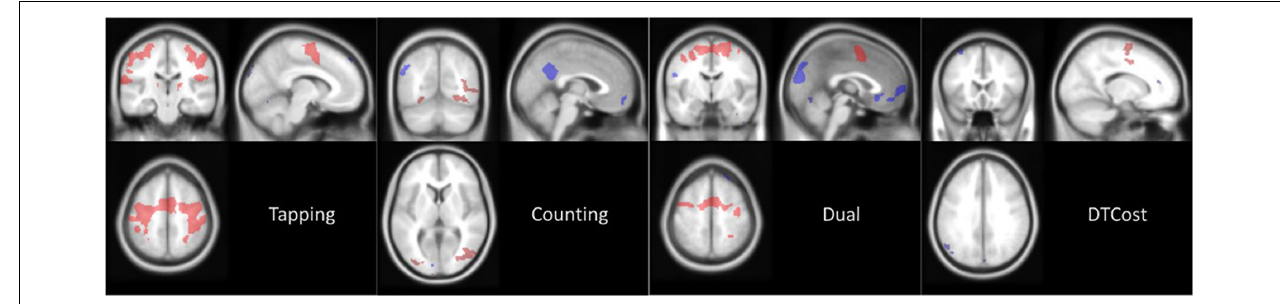
FIGURE 4 | Main effect of task at baseline. Average brain activation at session 2 (BDC-7) for the HDBR + CO 2 cohort. Contrast images are thresholded at p < 0.001 with a threshold of k = 10 for cerebral cluster and k = 6 for cerebellar clusters. Red areas are clusters of activation and blue areas are clusters of deactivation, both relative to values at